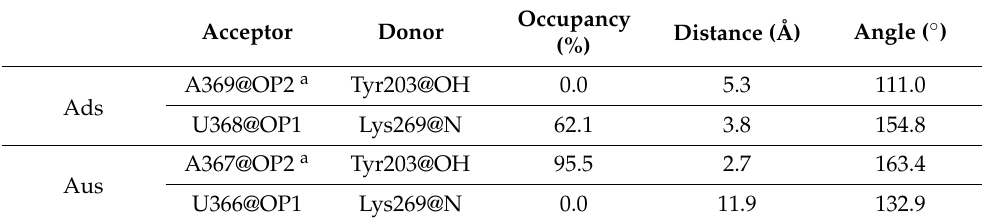
Table 2. Occupancy of hydrogen bonds for Ads and Aus.